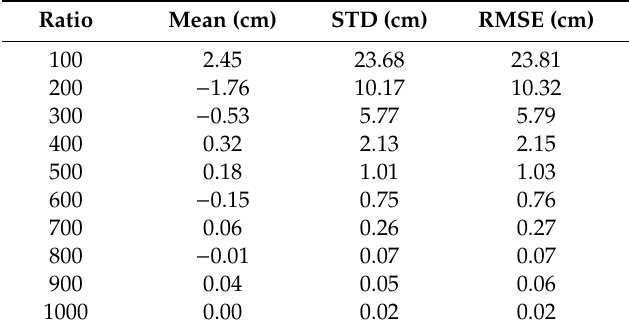
Figure 11. Scatterplot of the RMS of the proposed method-based subsidence estimation errors versus the ratios of the amount of random points to the area of the corresponding extraction element. Table 3. Mean, STD and RMS of the proposed method-based subsidence estimations errors under different ratios of the amount of random points to the area of the corresponding extraction element.